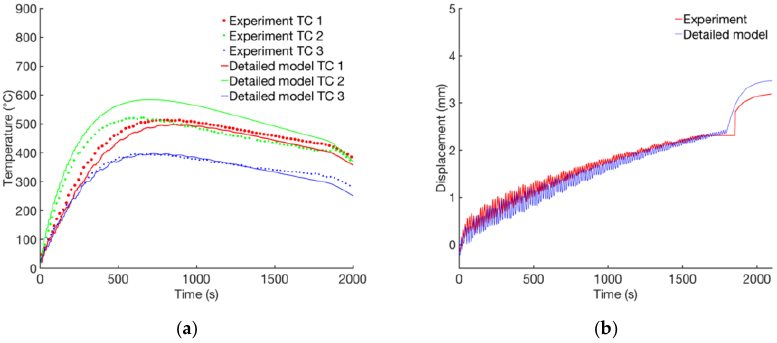
lumped models. When the results were compared, the same locations as in the measurements were used for the lumped models and for the reference model with fine mesh.